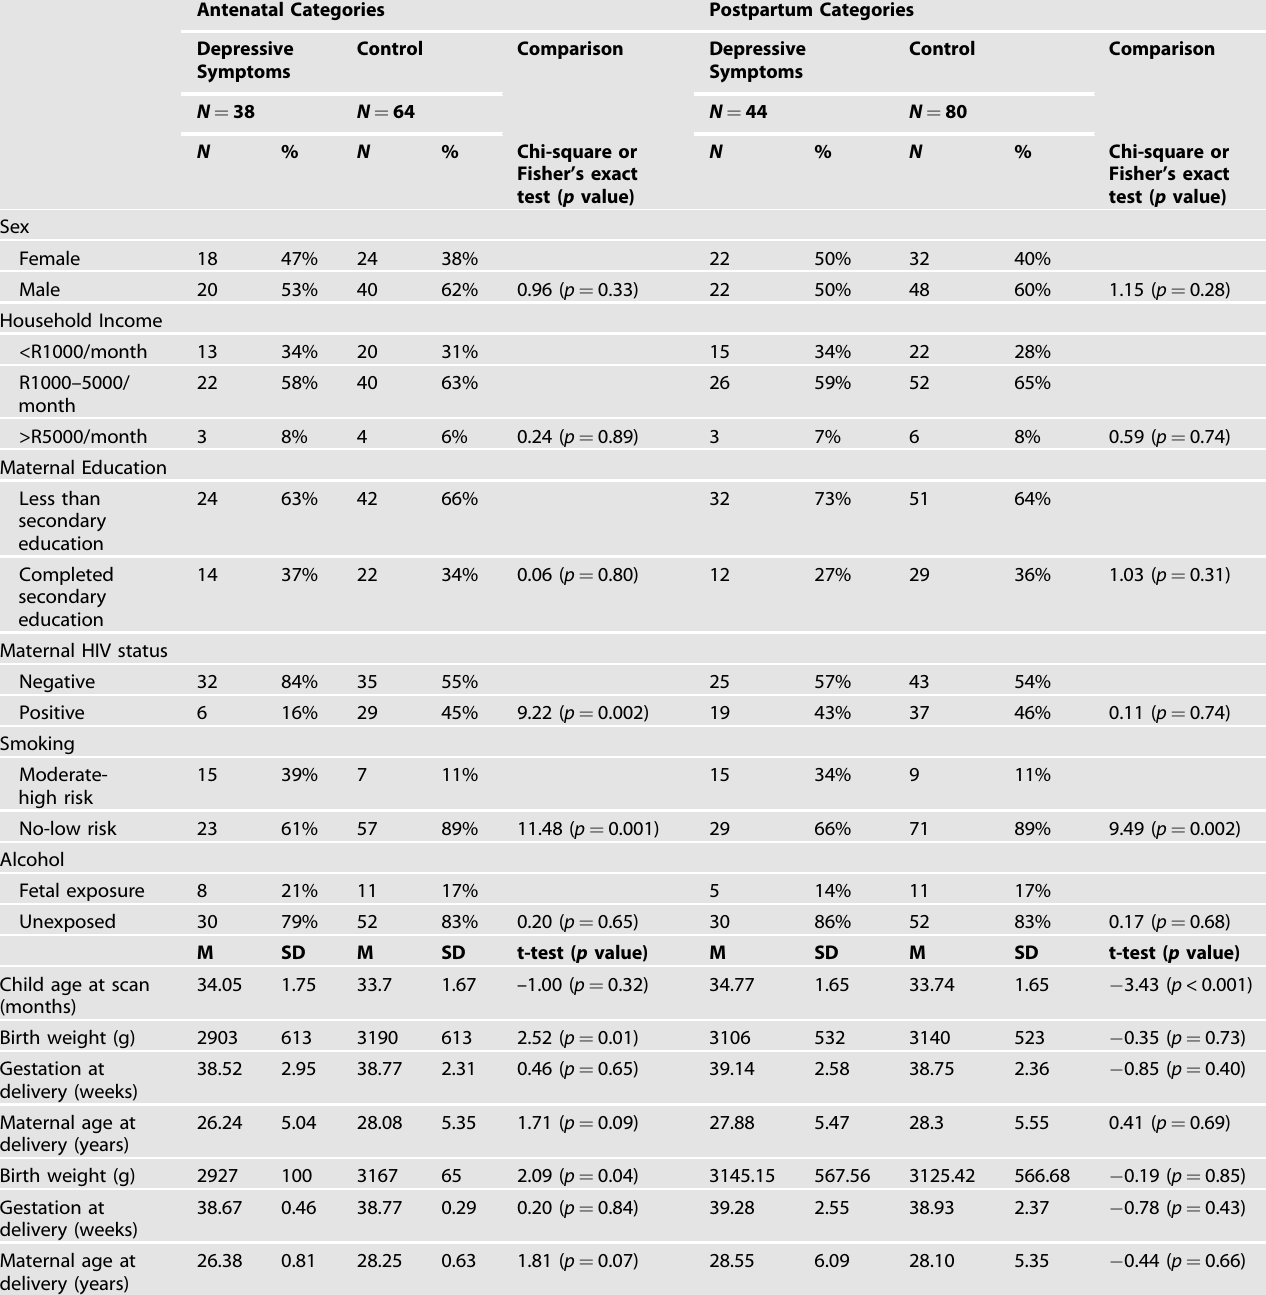
Table 1. Demographic characteristics by antenatal and postpartum depression